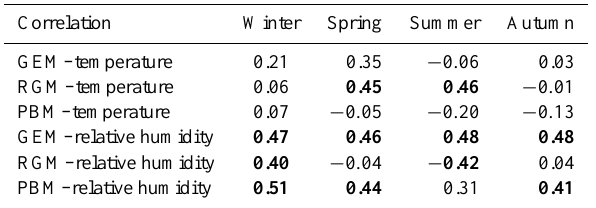
Table 3. Correlation coefficients between mercury species and me- teorological factors in different seasons.